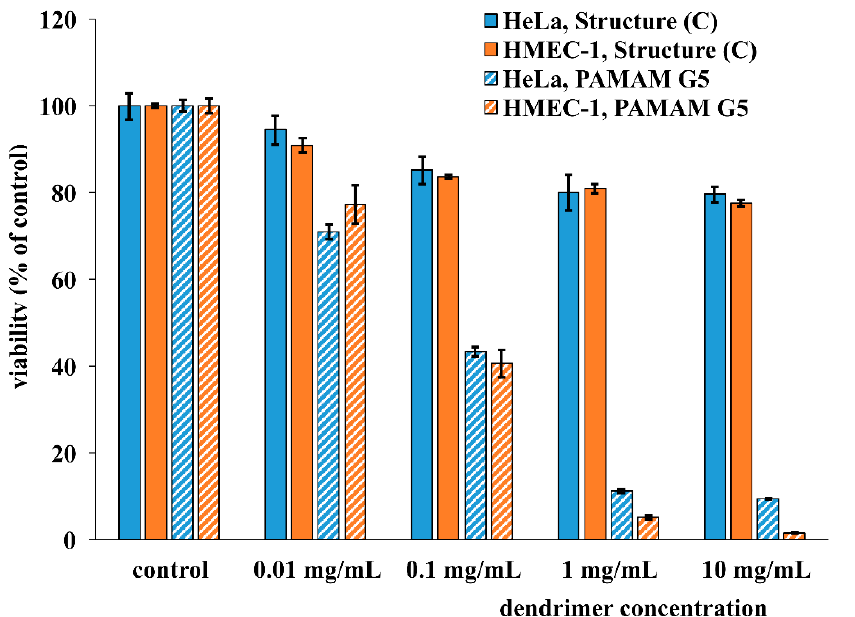
Figure 4. Cytotoxic effects of PAMAM [G5:G3-(TREN)]- N -(4-carbomethoxy) pyrrolidone terminated tecto(dendrimer) (C) and PAMAM (G5) dendrimer on HeLa and HMEC-1 cells. Cell viability was determined by the resazurin assay after 24 h treatment with dendrimers. Data are presented as percentage of viability of control (untreated) cells. Error bars represent the standard error ( n = 10).